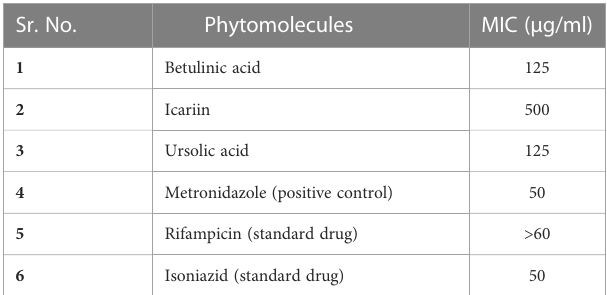
TABLE 1 MIC of each compound against the in vitro generated dormant cells of M. smegmatis . Sr. No.